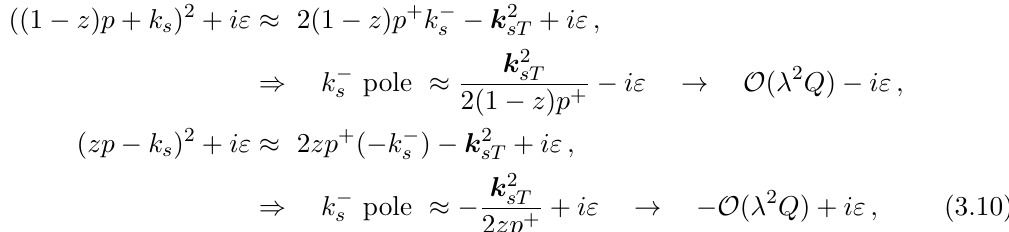
integration is not pinched, while in (b), the k − s